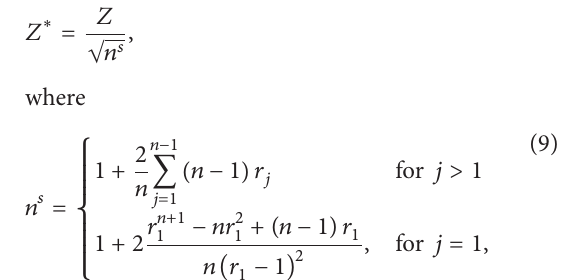
𝑍 follows the standard normal distribution with a mean of zero and variance of one under the null hypothesis of no trend in the series. The null hypothesis is rejected if |𝑍| ≥ 𝑍 1−𝛼/2 at the confidence level of 𝛼 , where 𝑍 1−𝛼/2 is the (1 − 𝛼/2) - quantile. If 𝑍 is positive (negative), the series 𝑃 has an upward (downward) trend. At 𝛼 = 0.05 , if |𝑍| > 1.96 , then the trend is significant. A correction factor 𝑛 𝑠 for limiting the influence of serial autocorrelation on the MK test is introduced [51,